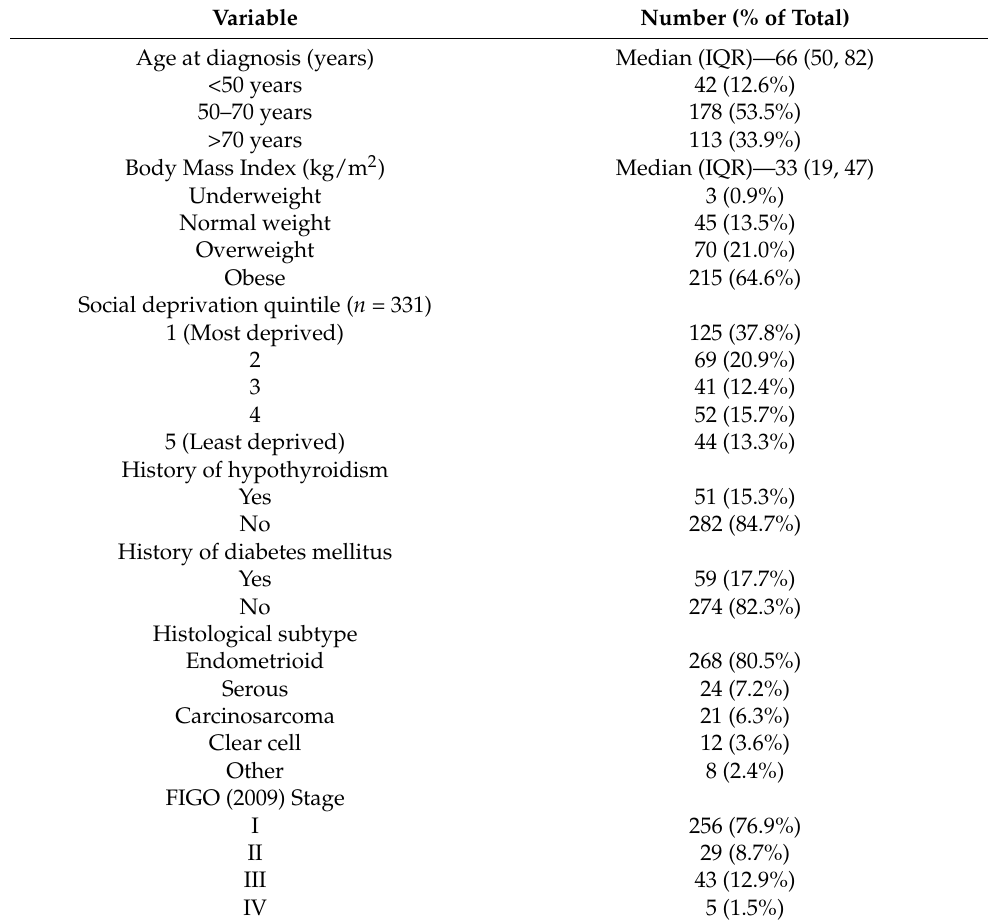
Table 1. Socio-demographic and clinical distribution of the study population ( n =